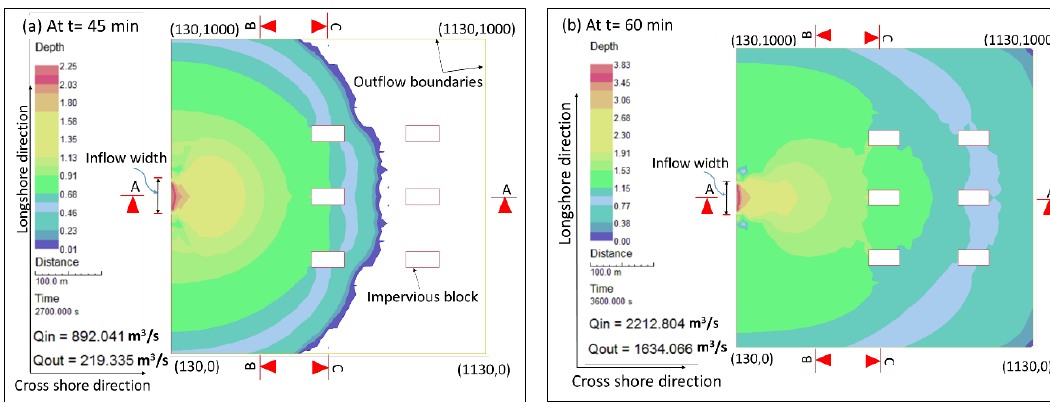
Figure 15 . Flood extent and water depths calculated by River-2D: ( a ) at t = 45 min and ( b ) at storm end (1.0 h), both under the rectangular load case (LC1).